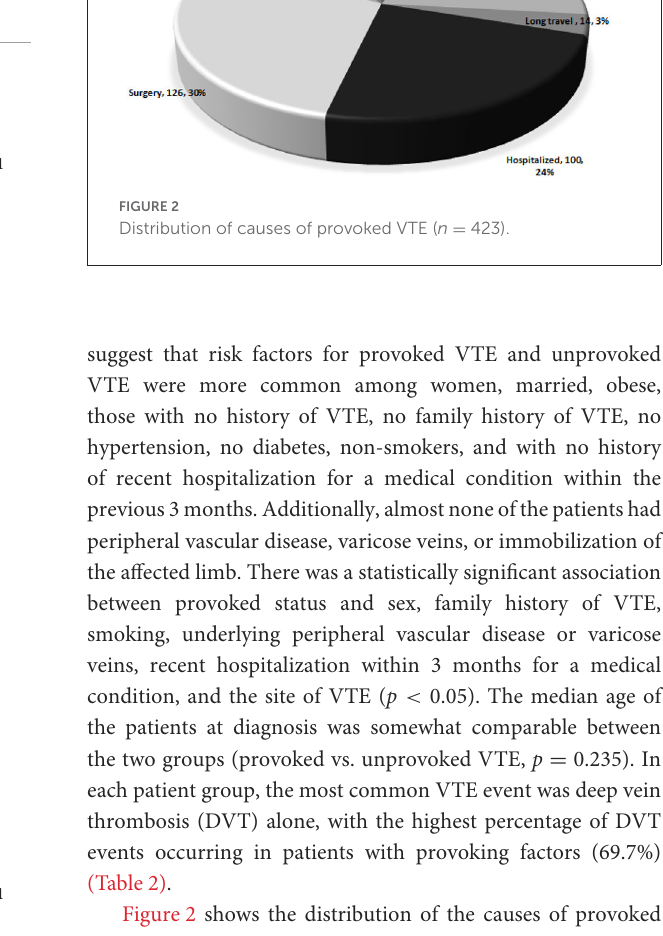
TABLE 2 Risk factors in patients with provoked vs. unprovoked venous thromboembolism. Characteristic Provoked VTE